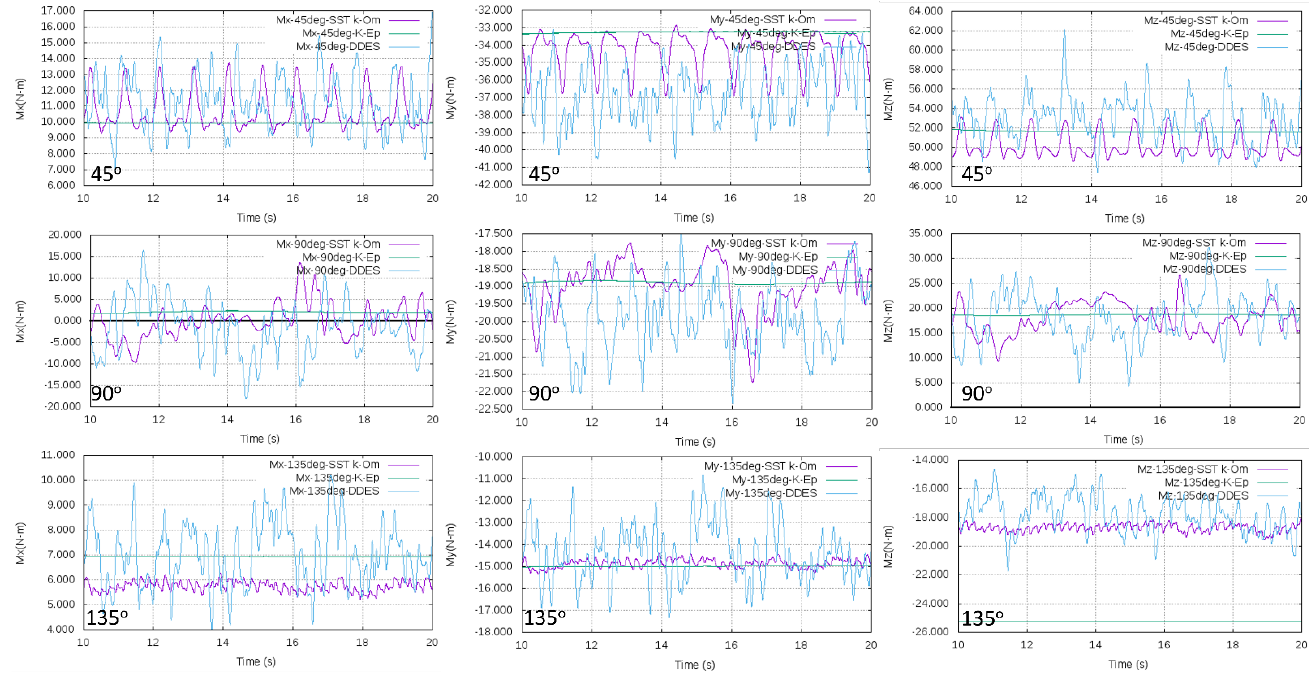
Figure 5. Relative comparison among moment time histories for the Tejo vessel model simulated using three different turbulence models. In the figure, the purple colour represents the SST K-Omega model, the green represents the K-Epsilon model, and blue represents the DDES model.